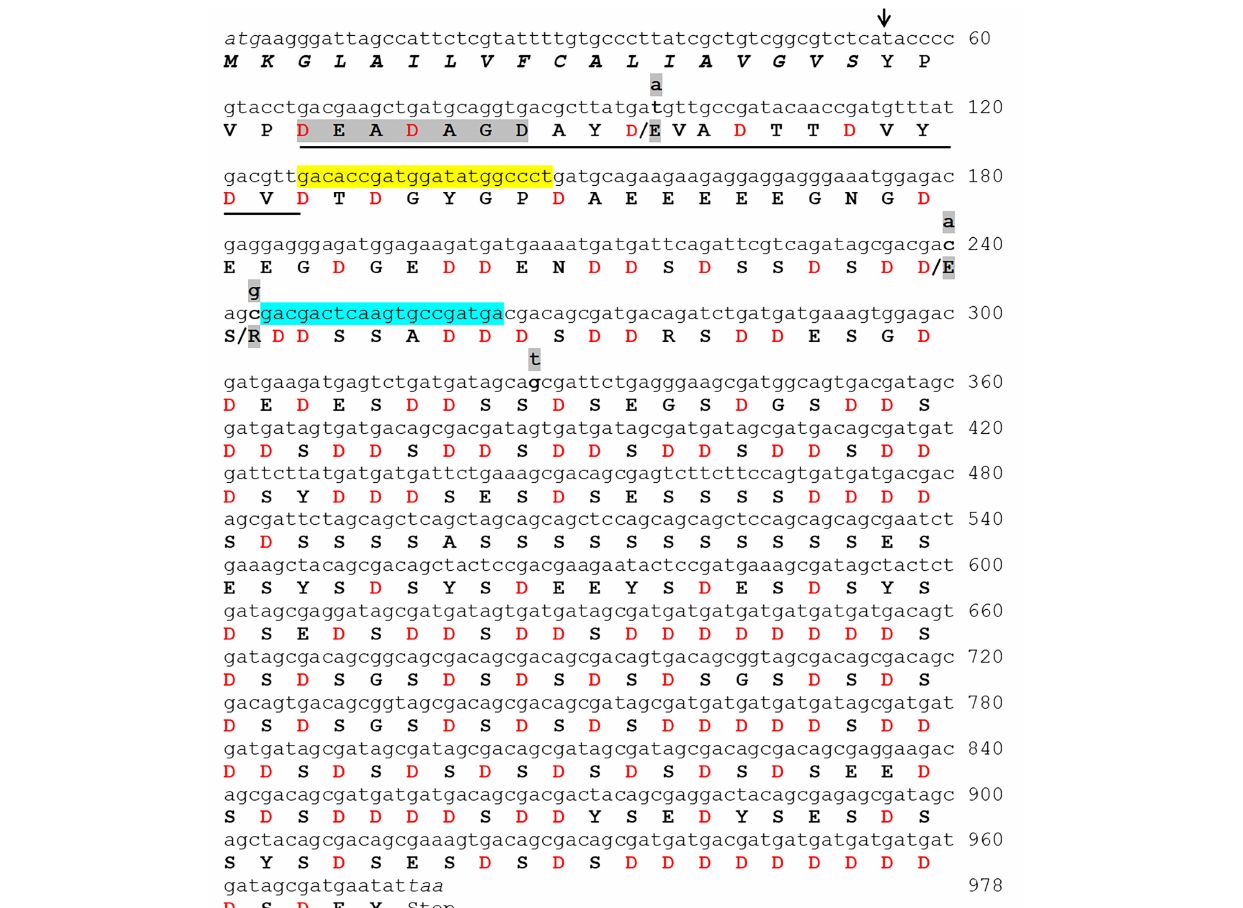
of folian-cv1 and cv1-MMP were not statistically different ( p = 0.992). Based on the averages, the expression of cv-actin is 2–3 orders of magnitude higher than either cv1-MMP and